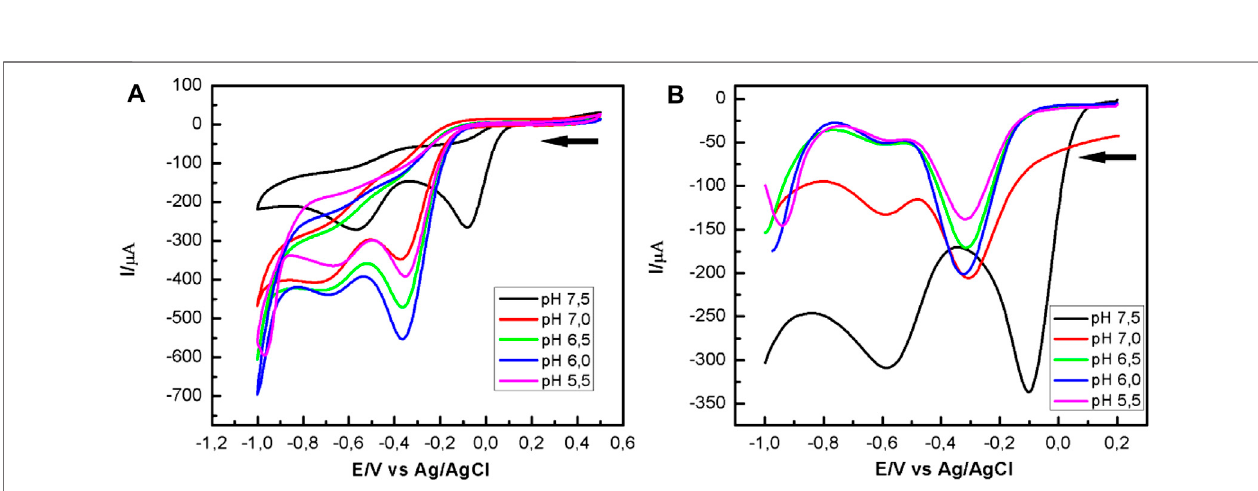
FIGURE 4 | Potentiodynamic response of CoPc-modi fi ed OPG electrodes in Mueller Hinton broth, in the presence of P. aeruginosa at different pHs . (A) Cyclic voltammograms recorded at 100 mV/s; (B) Square waves voltammograms. Experimental SWV parameters: initial potential -0.2 V, end potential 1.0V, step potential 5 mV, amplitude 20 mV, frequency 25 Hz, equilibration time 5